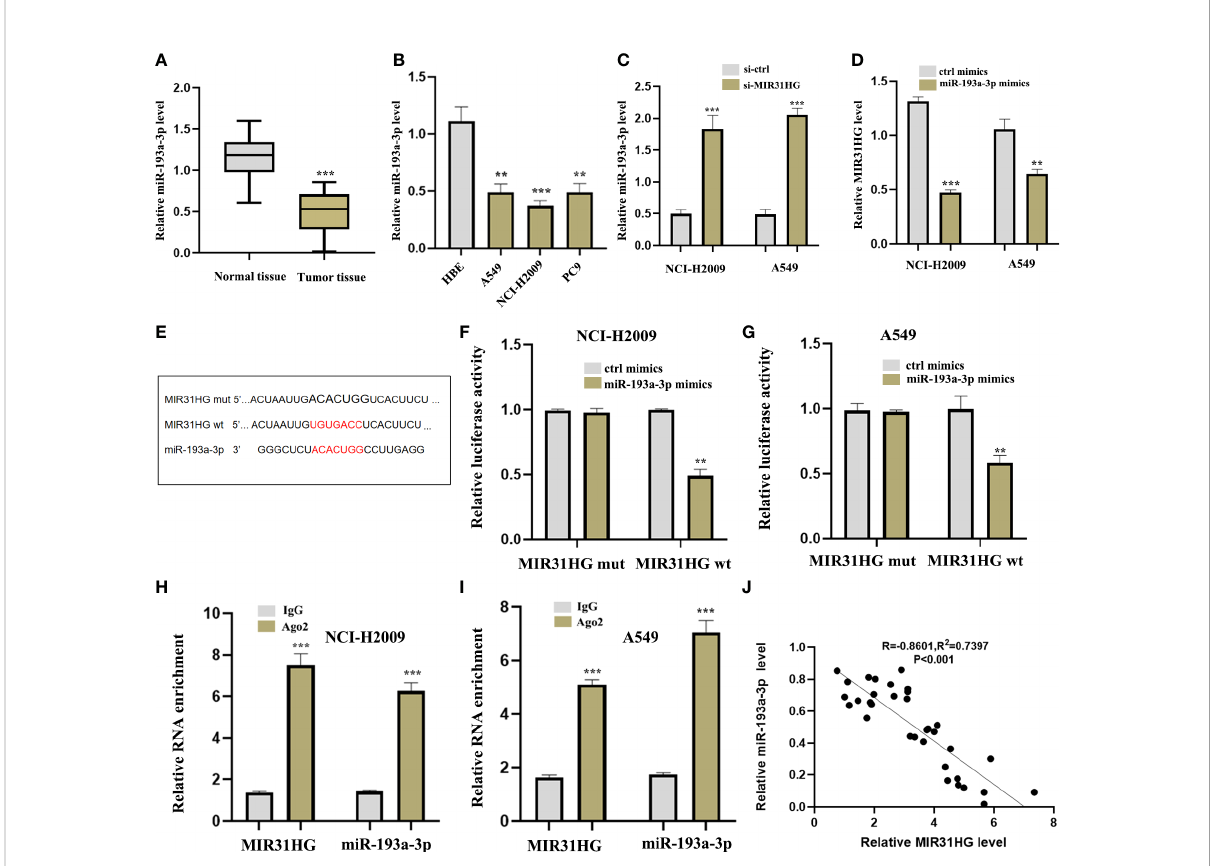
FIGURE 9 lncRNA MIR31HG acted as ceRNA for miR-193a-3p. (A) miR-193a-3p expression in lung adenocarcinoma (LUAD) specimens compared with normal tissues as detected by qRT-PCR. *** p < 0.001 vs . normal tissue. (B) miR-193a-3p expression in different LUAD cell lines (A549, NCI- H2009, and PC9) relative to bronchial epithelioid cell (HBE) was estimated by qRT-PCR. (C) miR-193a-3p expression following si-MIR31HG transfection was assessed by qRT-PCR. (D) MIR31HG expression following miR-193a-3p overexpression was measured by qRT-PCR. (E) Schematic diagram of the predicted interacting sites. (F, G) The relationship between MIR31HG and miR-193a-3p in NCI-H2009 and A549 cells was performed by dual-luciferase reporter assay. (H, I) The immunoprecipitation of MIR31HG and miR-193a-3p in NCI-H2009 and A549 cells was determined by RNA immunoprecipitation experiment. (J) The relationship between MIR31HG and miR-193a-3p was investigated by Pearson ’ s analysis. ** p < 0.01; *** p <